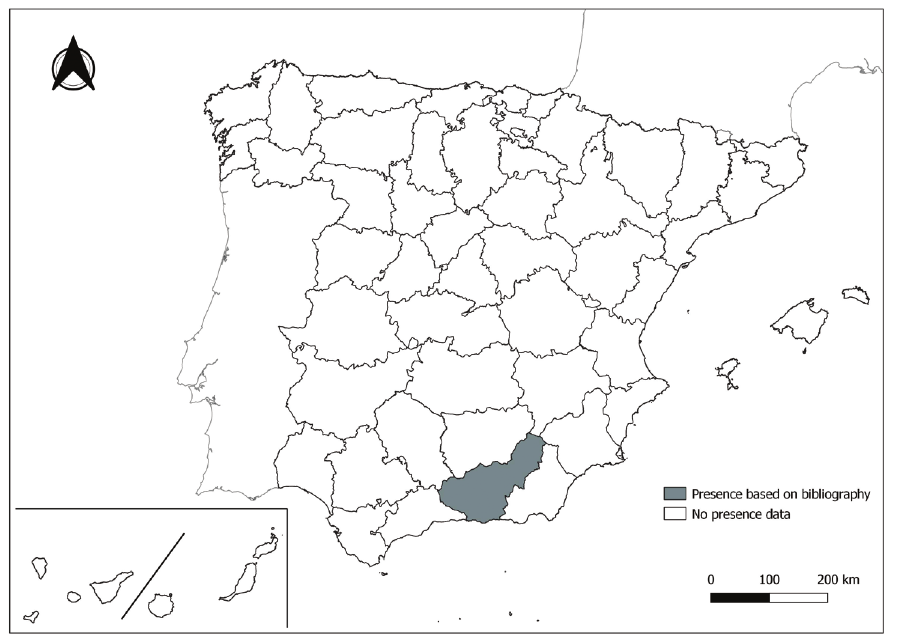
Figure 10. Distribution of Phlebotomus riouxi in